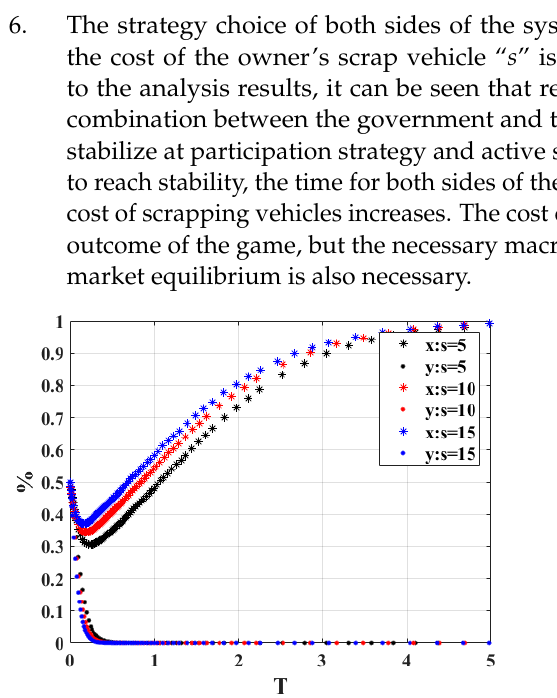
Figure 8. Sensitivity analysis of “ s ”.